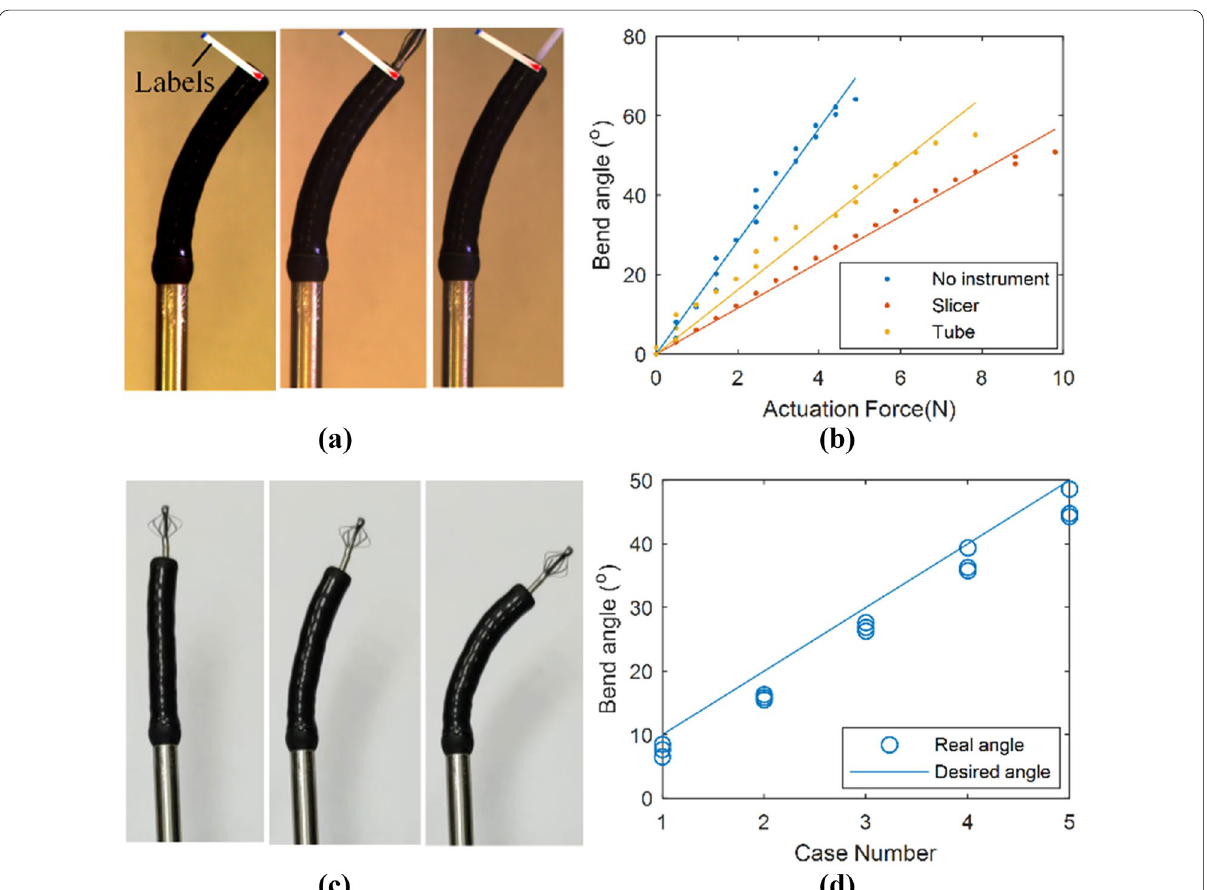
Figure 11 Evaluation of flexible